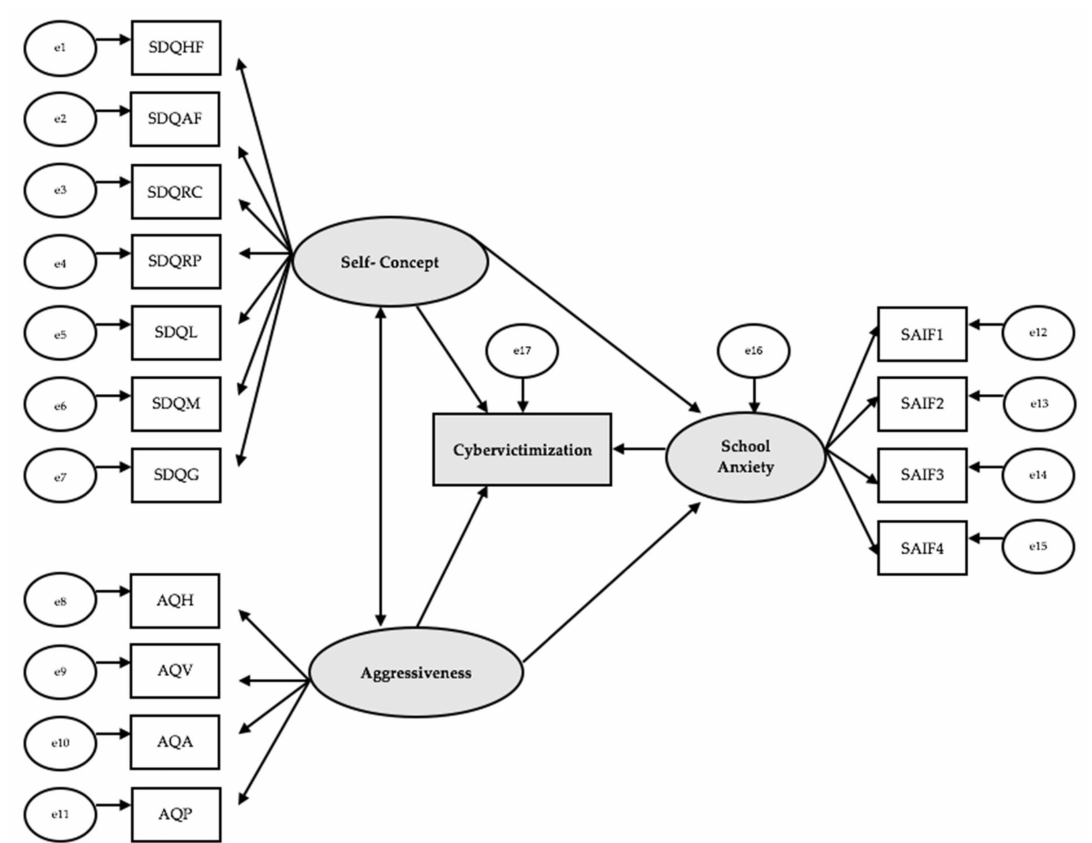
Figure 1. Model theories. Note: SAIF1: Anxiety related to assessment and academic failure; SAIF2: Anxiety related to victimization; SAIF3: Anxiety related to social assessment; SAIF4: Anxiety related to scholasticpunishment; AQH:Hostility; AQV:Verbalaggression; AQA:Anger; AQP:Physicalaggression; SDQHF: Physical ability; SDQAF: Physical appearance; SDQRC: Relationship with peers; SDQRP: Relationship with parents; SDQL: Self-concept in language; SDQM: Self-concept in mathematics; SDQG: General